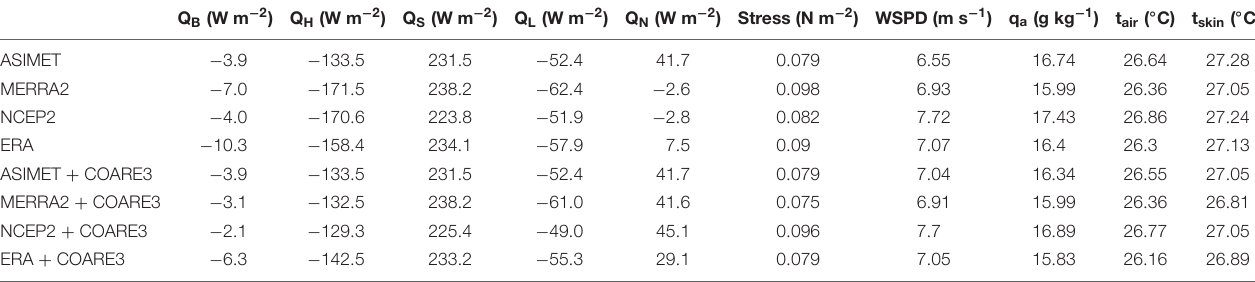
TABLE 2 | Averages over 11 years record of air-sea fluxes and surface meteorological values (directly given by reanalyses, and adjusted to common standard heights using COARE